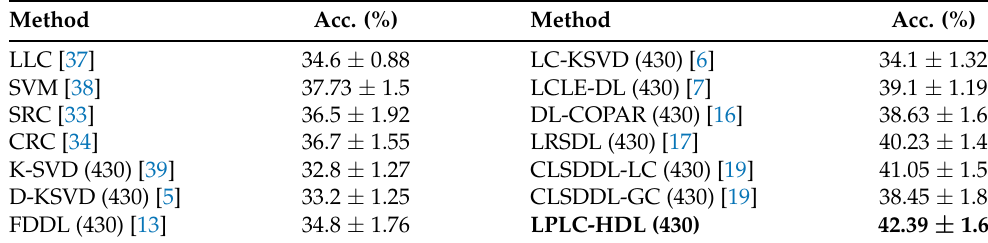
Table 4. The recognition rates (%) on the LFW face dataset.